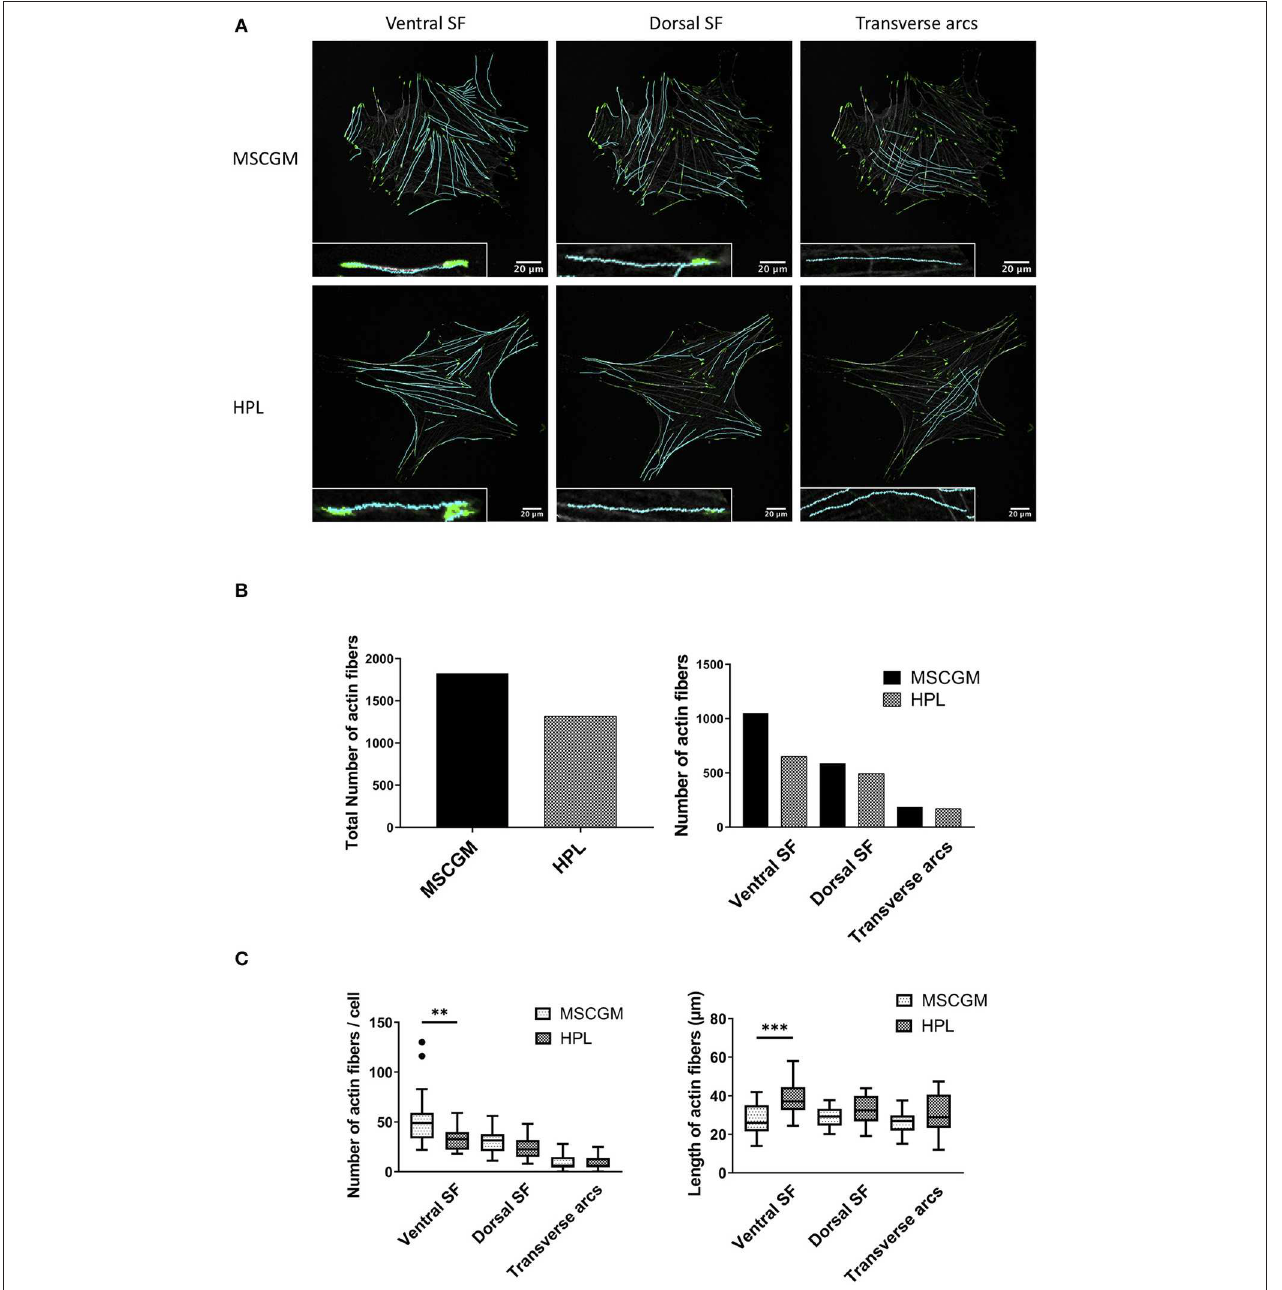
FIGURE 2 | Examination of cytoskeleton morphology. (A) Images of ventral, dorsal stress fibers and transverse arcs compared to the influence of MSCGM TM or MSCBM TM with 8% HPL. Higher magnification of the individual fibers is shown in the lower left corner. (B) Left: Total numbers of stress fibers. Right: Total number of stress fibers split in ventral, dorsal stress fibers and transverse arcs. (C) Left: Number of fibers per cells, Mann-Whitney test. Right: Median of the length per cell, unpaired t -test. The same 20 cells per media were compared in (B,C) . ** p < 0.01, *** p < 0.001.